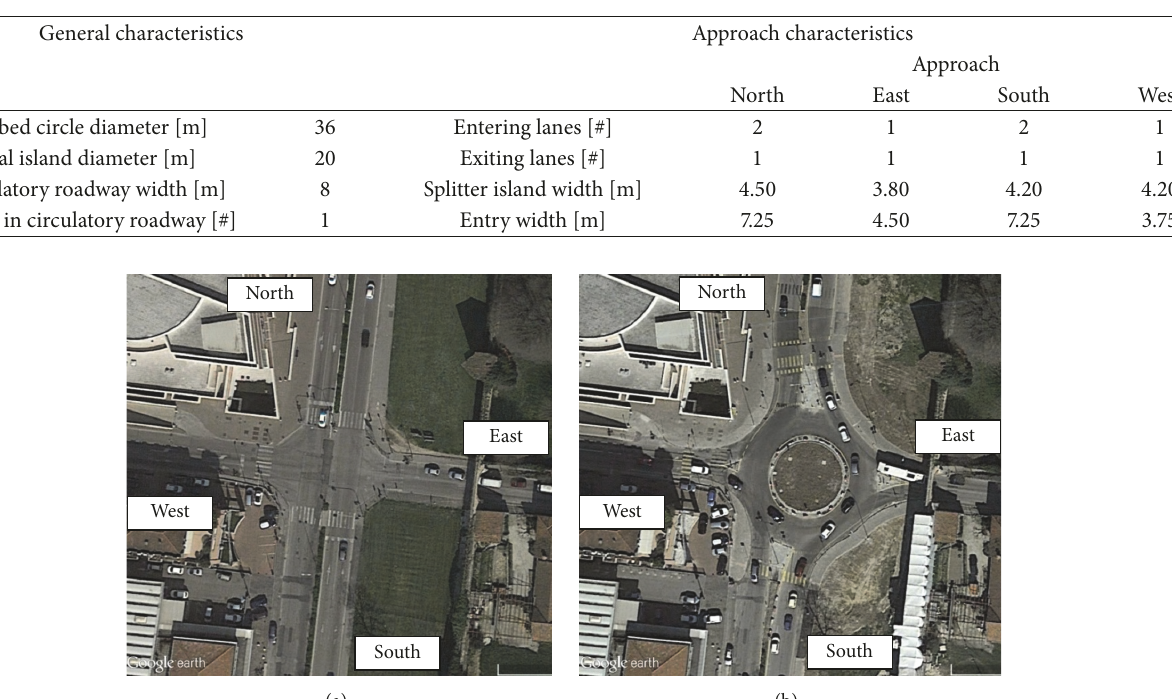
Table 3: Roundabout characteristics [4].